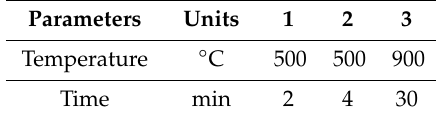
Figure 4. Optical microscope images of the ( a ) MSM varactor, ( b ) MOSOM varactor (without annealing), ( c ) MOSOM varactor (with 500 °C and 2 min of annealing), ( d ) MOSOM varactor (with 500 °C and 4 min of annealing), and ( e ) MOSOM varactor (with 900 °C and 30 min of annealing). Table 1. Experimental parameters used in the oxygen furnace annealing process.